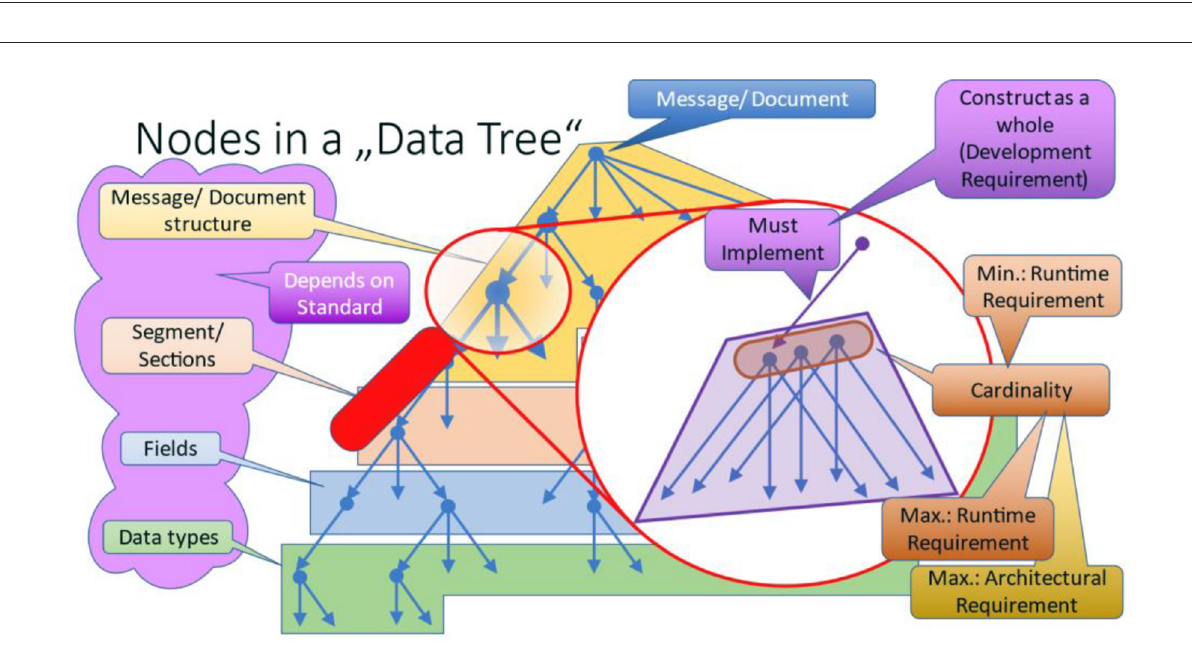
FIGURE8 Nodes in a data